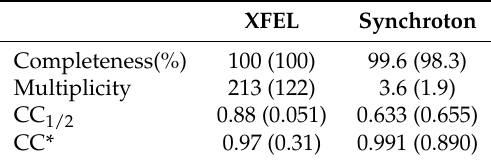
Table 1. Comparing typical data collection strategies of an X-ray free electron laser (XFEL) source and a synchrotron source shows how repeated measurements improve statistics in the former. A dataset collected at the European XFEL (EuXFEL) by Gisriel et al. measured approximately 60 times more reflections than a typical synchrotron data collection strategy, as shown by the multiplicity values, while also improving on the data quality indicators. Table adapted from Nat. Commun.